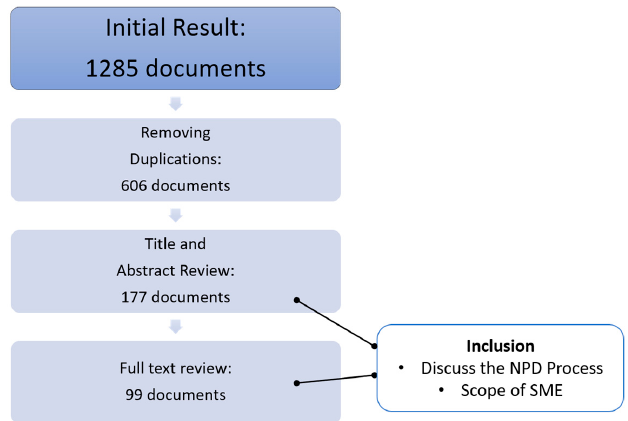
Figure 1. Articles filtering process.